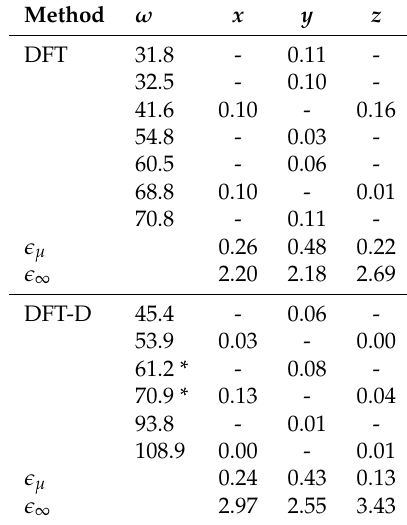
Table 4. Same description as Table 3, but for BPEth. Asterisks (*) are next to the vibrational modes shown in Figure